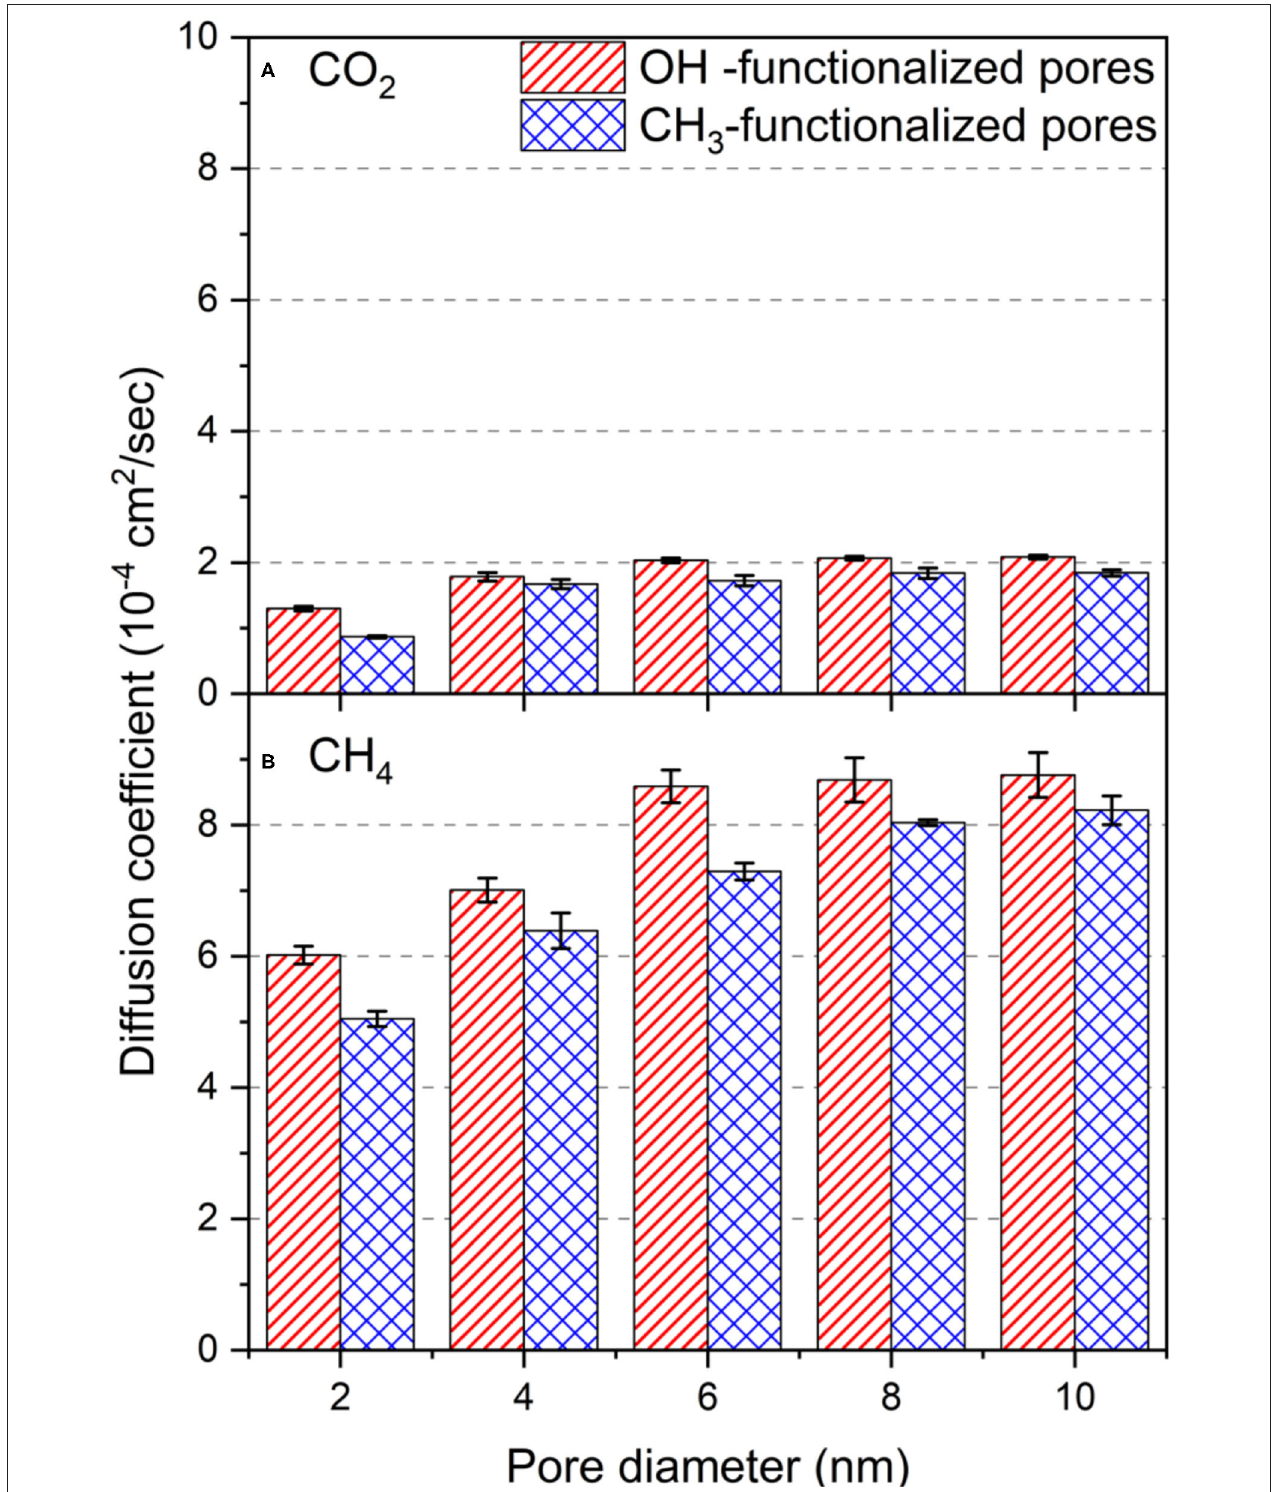
FIGURE 9 | The self-diffusion coefficient of (A) CO 2 and (B) CH 4 molecules in OH-terminated and CH 3 -terminated pores as a function of the pore diameter. Diffusion coefficients are averaged over the last 10 ns of the simulation time. Error bars represent the standard deviation from the mean values of the three different simulations.